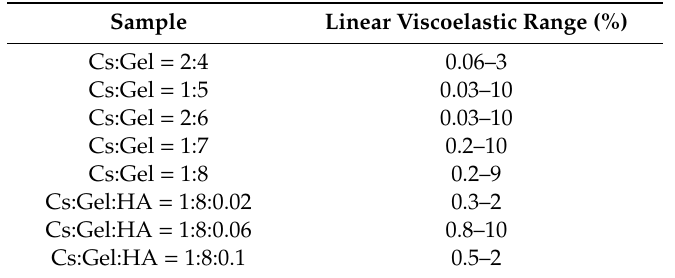
Table 3. Linear viscoelastic regions of various ratios of bio-ink.